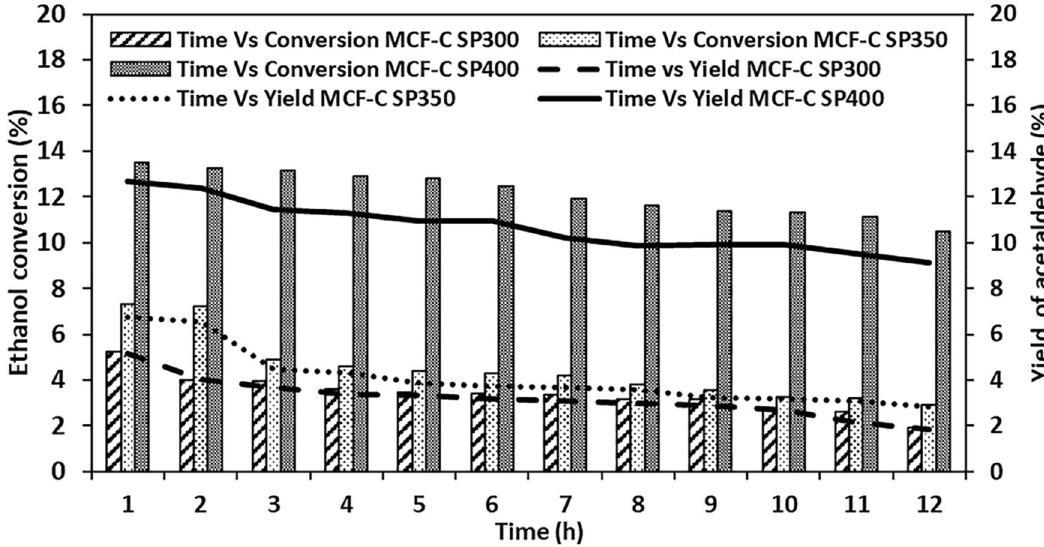
Figure 1. Ethanol Conversion and yield of acetaldehyde of all catalysts with regarding to ethanol